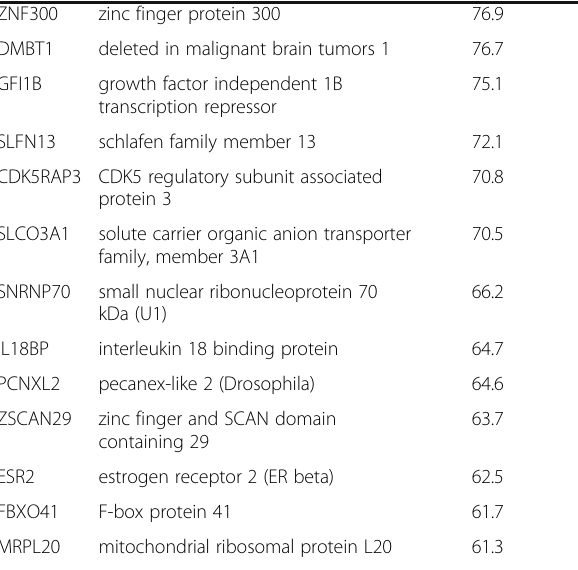
Table 2 Top 50 genes upregulated in idiopathic interstitial pneumonia (IIP) patients